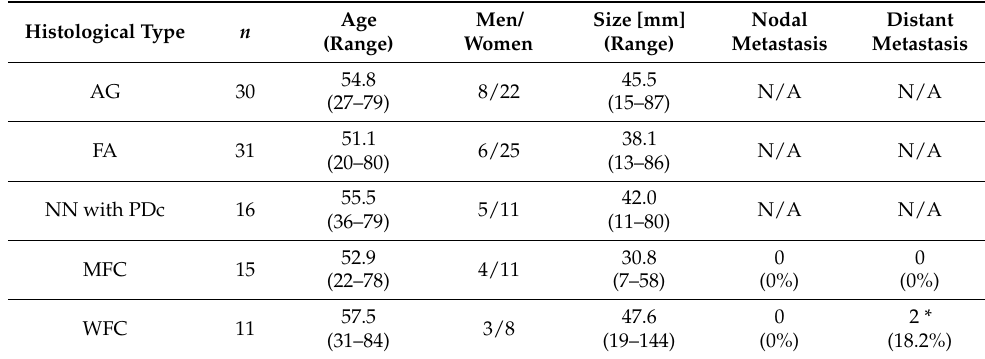
Figure 3. Representative histological images of thyroid follicular-patterned tumors used in this study. Adenomatous goiter ( a , e ); follicular adenoma ( b , f ); minimally invasive follicular carcinoma ( c , g ); widely invasive follicular carcinoma ( d , h ). The scale bars indicate 2 mm in ( a – d ), 100 µ m in ( e , f ) , and 500 µ m in ( g , h ). Table 1. Clinicopathological profiles of the patients in this